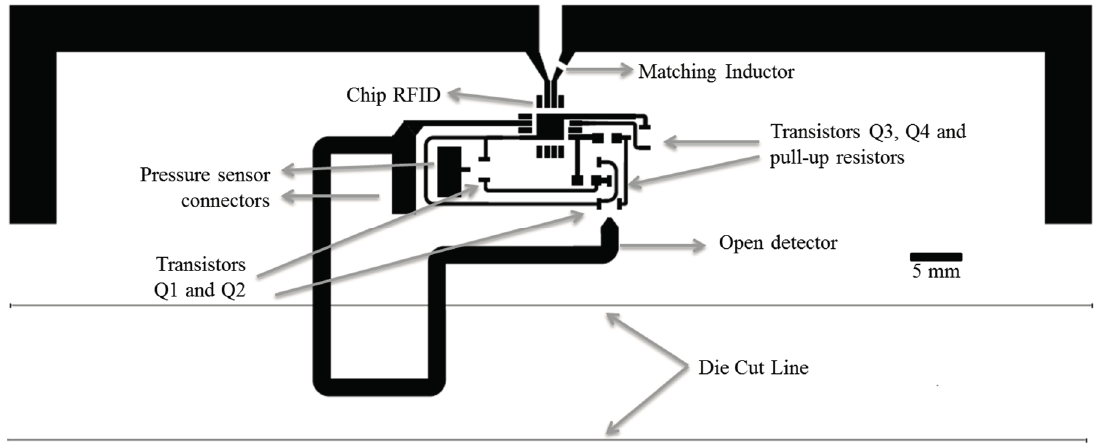
Figure 2. Layout of the RFID tag comprising a dipole antenna, an RFID chip and the sensor architecture. Components have been labeled for better